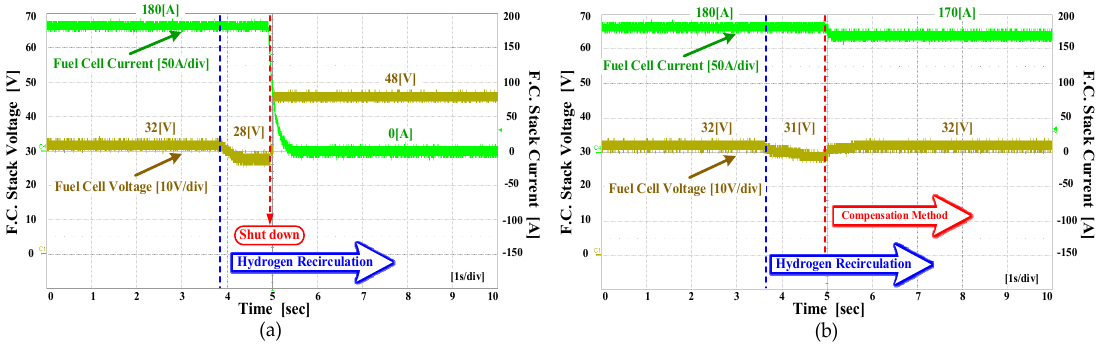
Figure 15. Output waveforms during hydrogen recirculation ( a ) not applied compensation method and ( b ) applied proposed compensation method.